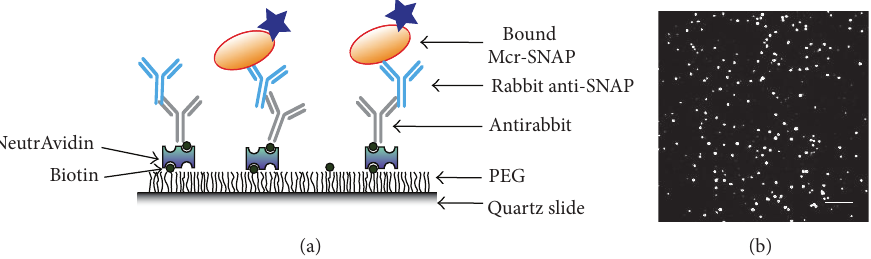
Figure 3: SiMPull experiments for protein count measurement. (a) Anti-SNAP antibody immobilized on a microscope slide using biotin. The antirabbit antibody captures SNAP labeled McrG. (b) A TIRF microscopy image obtained for captured McrG, where each spot corresponds to at least one immobilized